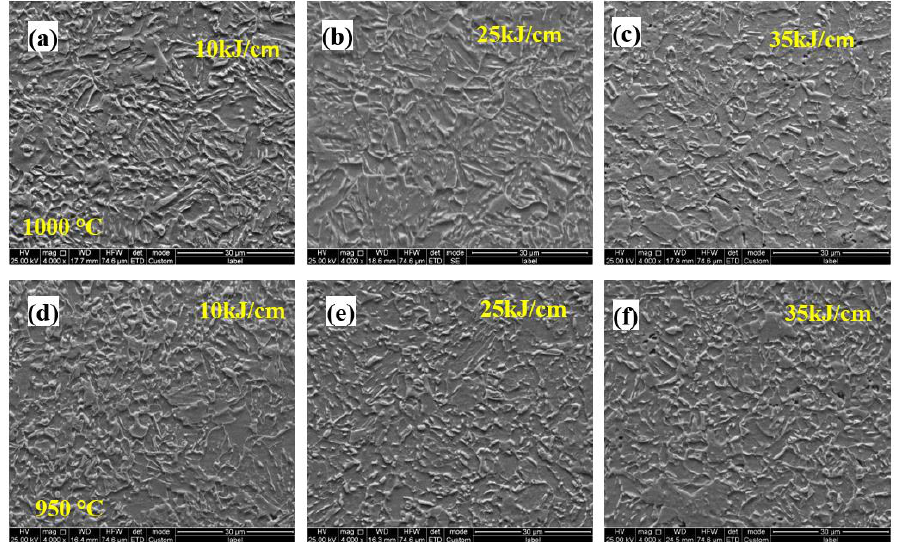
Figure 8. Microstructure of FGHAZ with 0.062% Nb content under various heat input and peak temperature: ( a ) 10 kJ/cm at 1000 °C; ( b ) 25 kJ/cm at 1000 °C; ( c ) 30 kJ/cm at 1000 °C; ( d ) 10 kJ/cm at 950 °C; € 25 kJ/cm at 950 °C; ( f ) 30 kJ/cm at 950 °C.